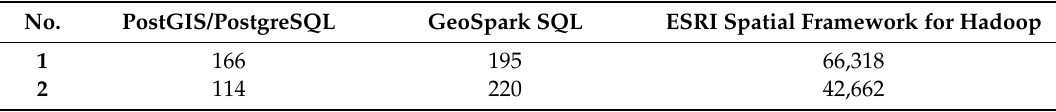
Table 11. Performance of window queries (in milliseconds).